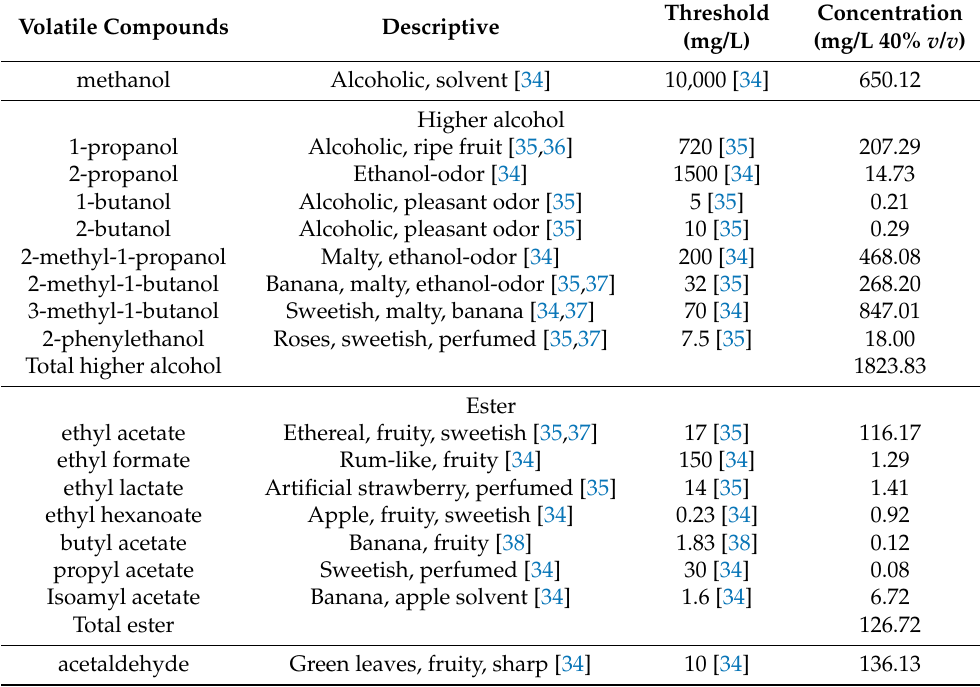
Table 4. Volatile compounds of fruit spirits from sour cherry.